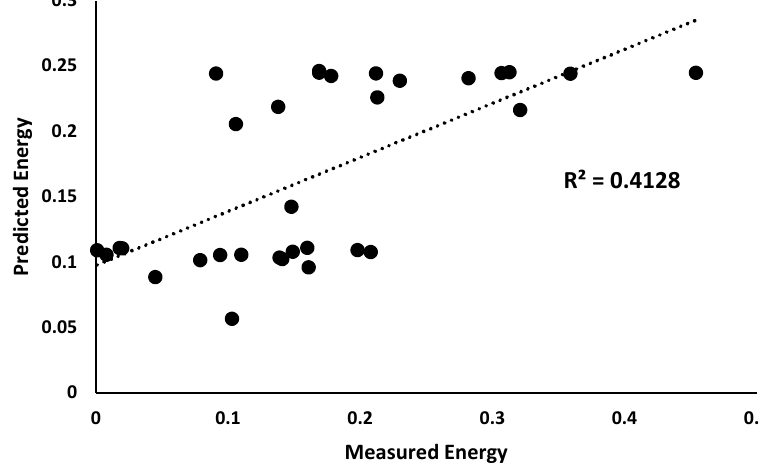
Figure 9. Comparing calculated and inference energy consumption by the regression model. Table 3. Regression statistics and coefficient values for the regression equation of energy prediction.